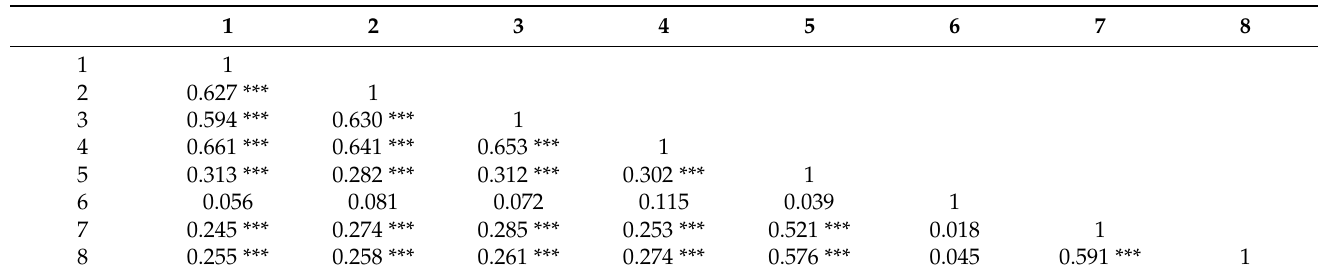
Table 3. Correlation analysis among variables.